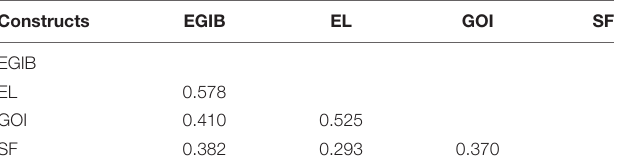
TABLE 4 | Heterotrait-Monotrait (HTMT) ratios.